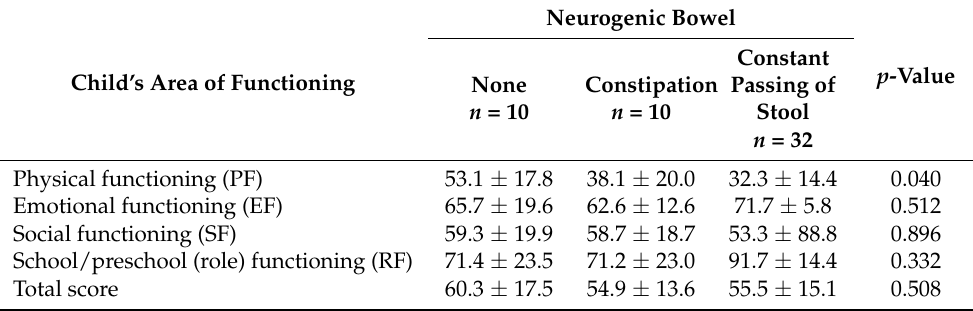
Table 6. Basic statistics ( M ± SD ) for children’s functioning scores, broken down by the presence or absence of a neurogenic bowel, with the significance of the test results.